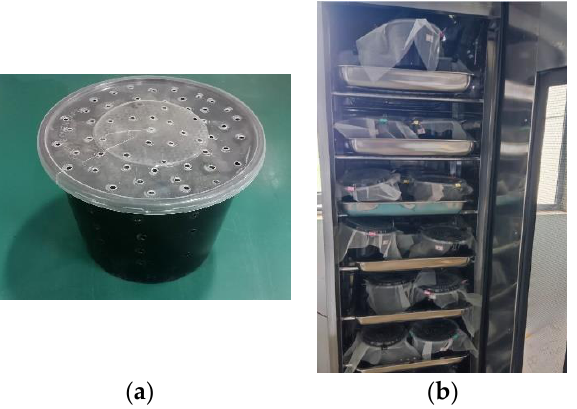
Figure 1. Composting devices: ( a ) culture container; ( b ) compost bin.